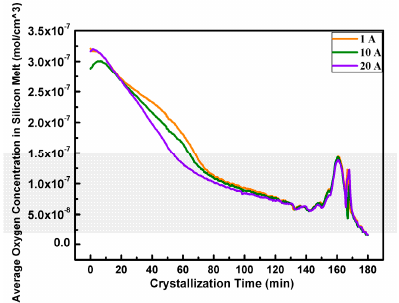
Figure 9. The average concentration of oxygen in the silicon melt.